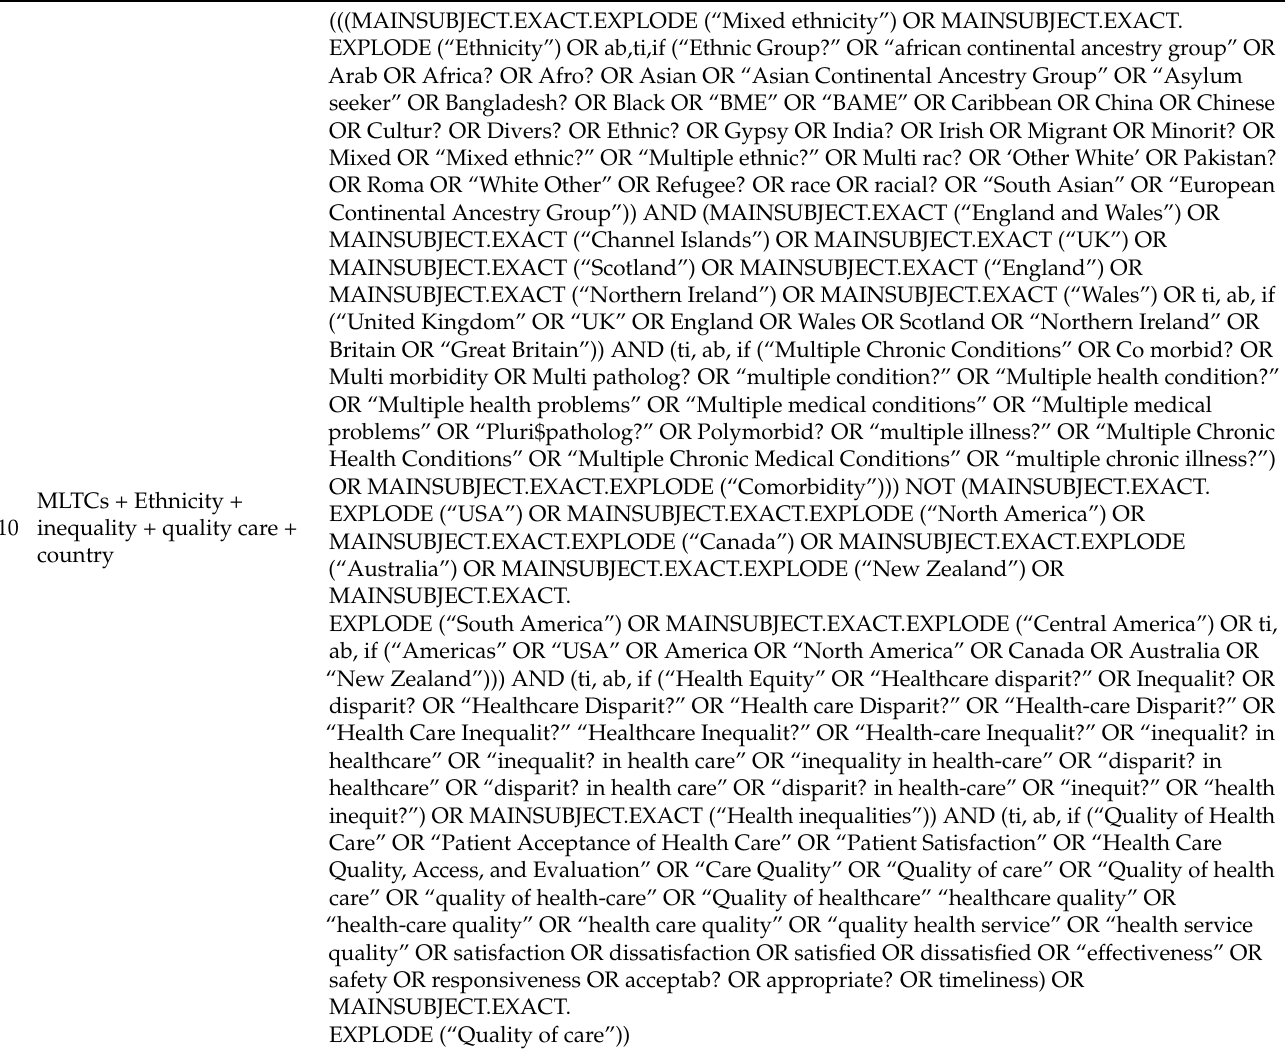
Table A1. Search terms used when searching Applied Social Sciences Index and Abstracts.